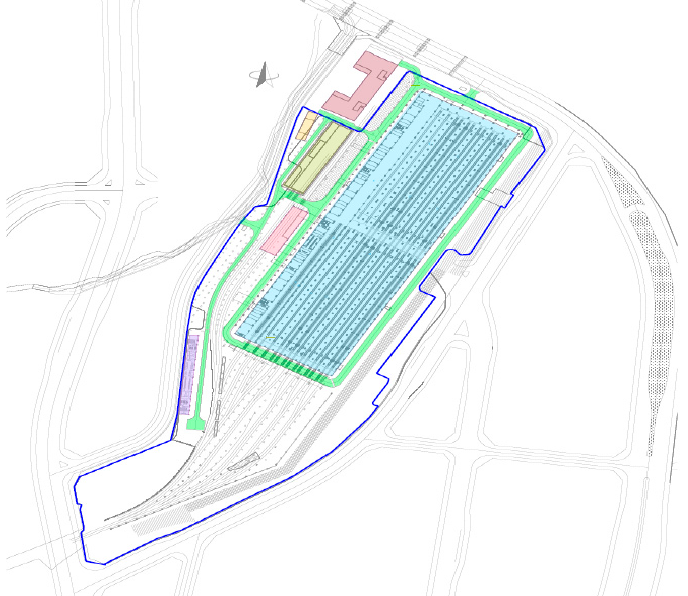
Figure 3. Location map of fire scene in fireproof insulation board and throat area.